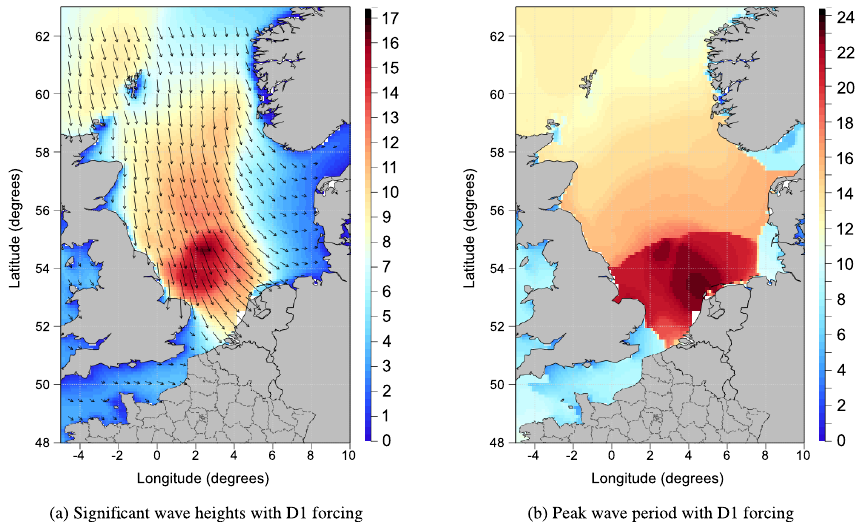
Figure 13. Significant wave heights (metres; a ) and peak wave period (seconds; b ) from the wave model MFWAM with D1 winds outputs on the peak of the storm at 00:00UTC on 1 February 1953. Mean wave direction is shown with black arrows in (a) when significant wave height are greater than 1.5m.